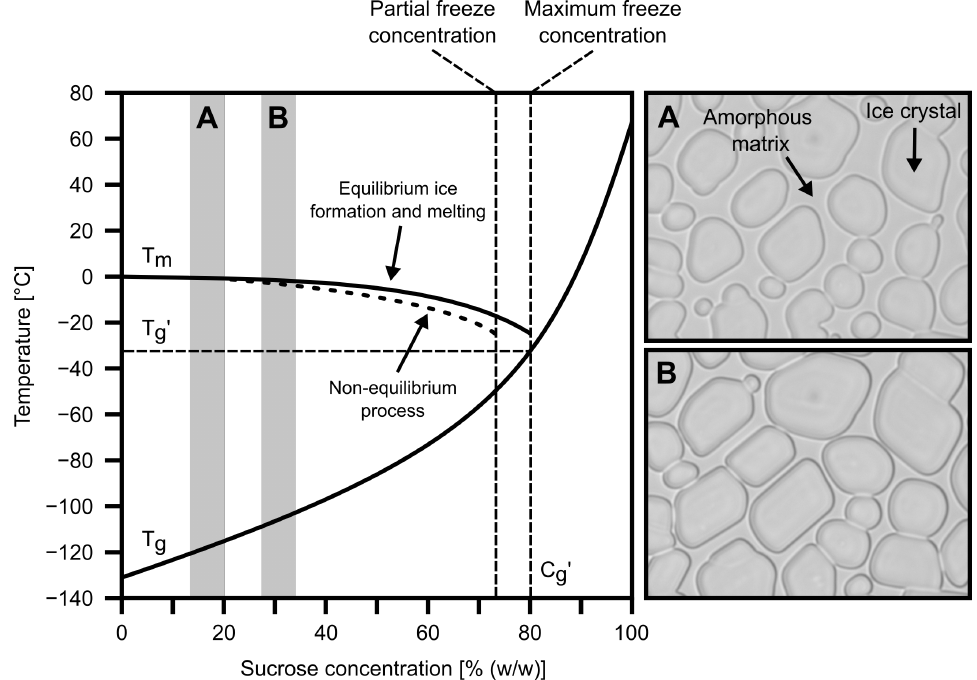
Figure 1. Simplified phase diagram of a sucrose-water system ( left ) and exemplary microscopy pictures ( right ) of a cooled sucrose solution (based on Zhao & Takhar